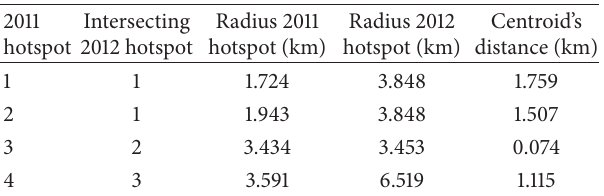
Table 2: Endema of bilateral Reinke disease—comparison results of the hotspots obtained for the years 2011 and 2012.